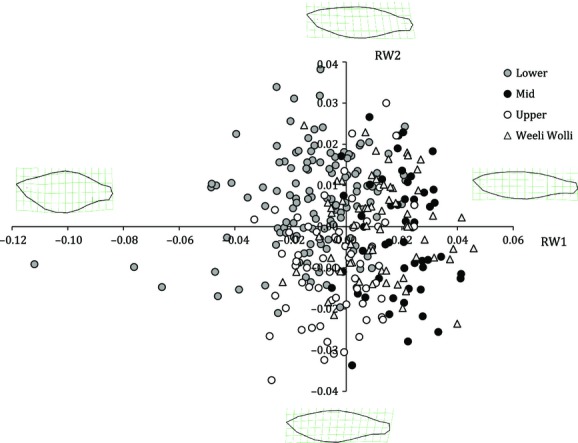
Morphological variation in RW1 and RW2 characterized by three subcatchments of the Fortescue catchment (upper, mid, and lower; white, black, and gray symbols). Weeli Wolli Creek sites (with artificially modified flow) are shown separately (triangle symbols) as they vary from the typical upper subcatchment pattern. Images illustrate the extreme morphologies represented by each axis.